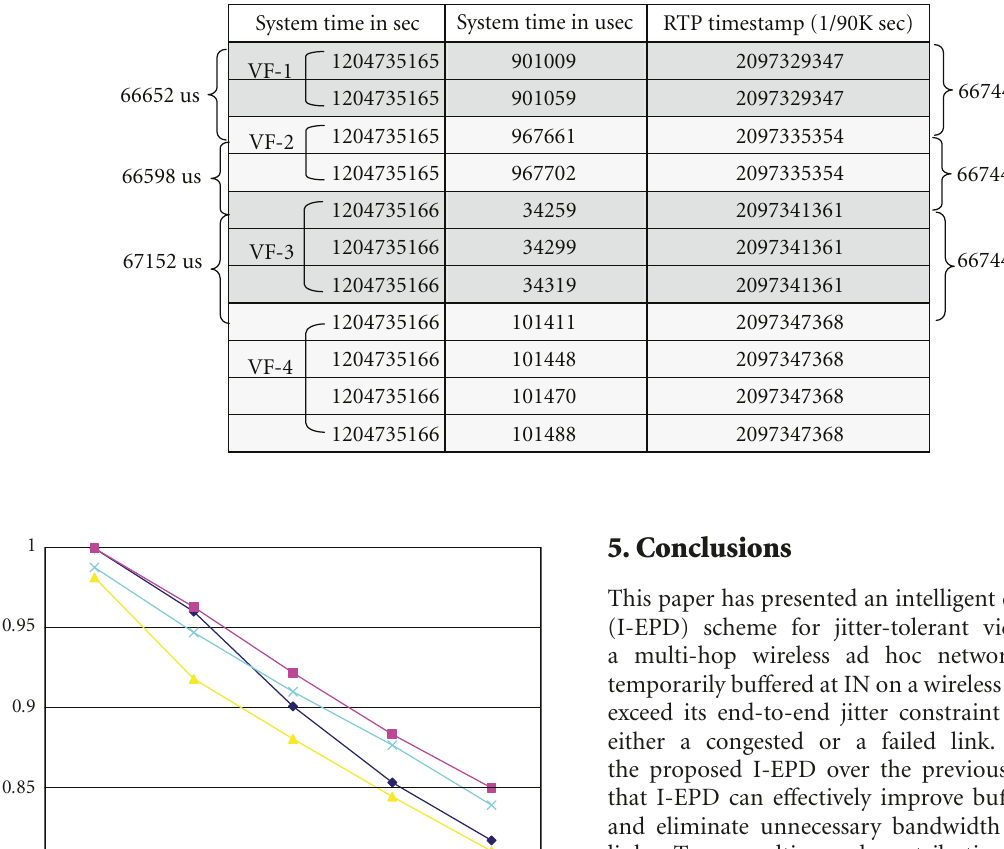
Table 3: System time versus RTP timestamp at a video server.